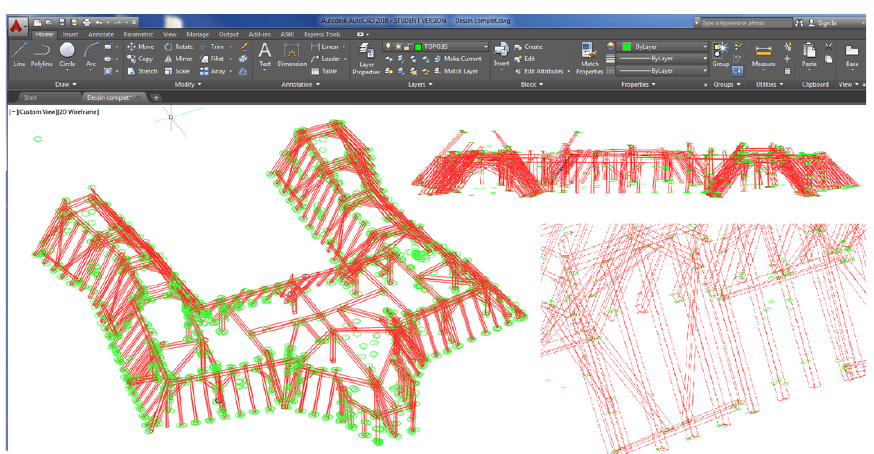
Figure 4. Truss structure of Haut-Kœnigsbourg Castle